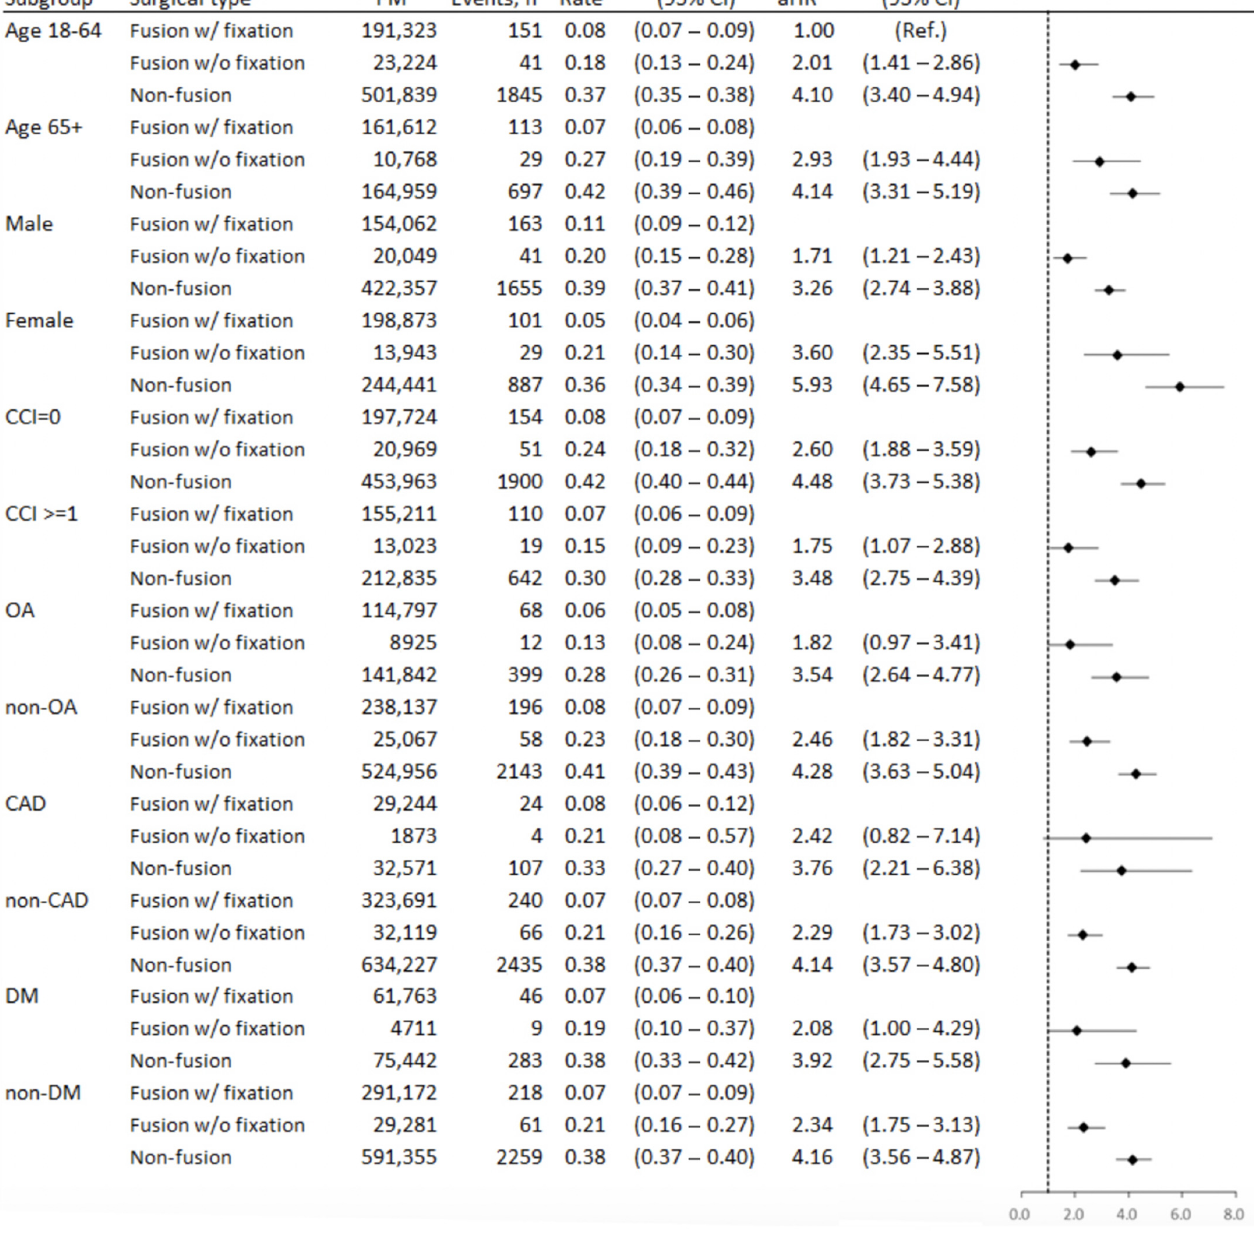
Figure 3. Subgroup analysis of incidence and multivariate Cox proportional hazard ratio of 1-year spine reoperation. Abbreviations: aHR, adjusted hazard ratio; CCI, Charlson comorbidity index; CAD, coronary artery disease; DM, diabetic mellitus; OA, osteoarthritis; and PM, people/month.